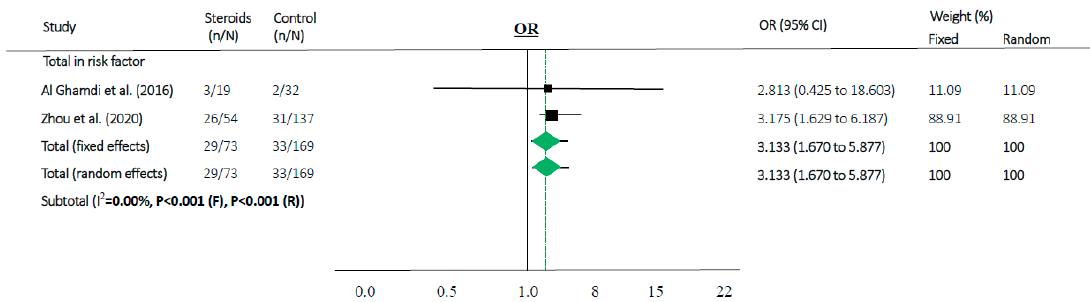
Figure 4. Association between steroids and mortality of studies about “risk factor”. Studies are presented as country study (study [year]). Meta-analysis was performed using an odds ratio (OR). High heterogeneity (I 2 > 50%) was observed in the studies of total intervention and steroids as